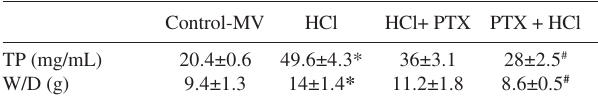
Table 2 - Effects of pentoxifylline (PTX) treatment before or after hydrochloric acid (HCl) instillation on the levels of total protein (TP) in bronchoalveolar lavage and wet-to-dry ratio (W/D). Data are shown as mean±SD.